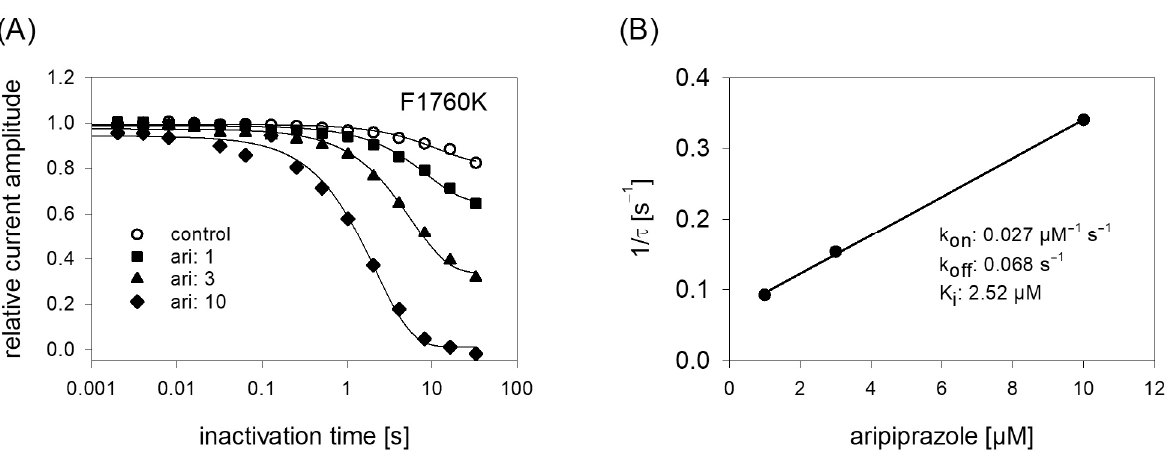
Figure 11. Time course of block development at the F1760K mutant. ( A ) Identical experiments as shown by Figure 6 were carried out with the F1760K mutant. Note: differently to the wildtype, time course of block development for the mutant can be described with one single exponential function. ( B ) Inverse of the time constants versus the concentration of aripiprazole. Listed fit parameters refer to this particular experiment. Altogether, a K i of 2.39 ± 0.28 was estimated.